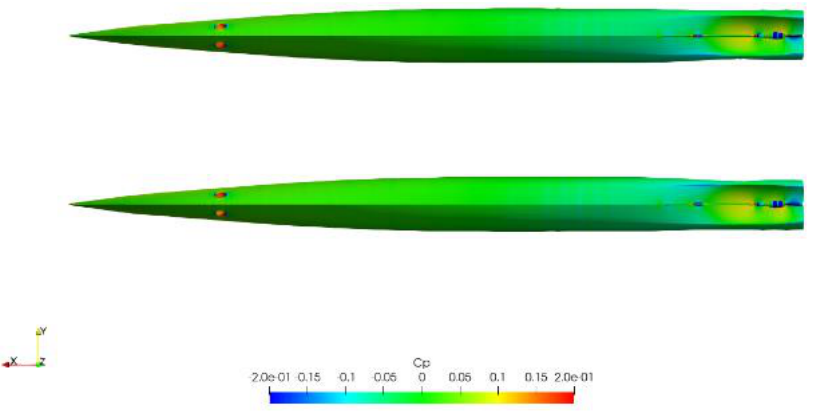
Figure 12. Cp distribution on the demihulls at 23 knots.